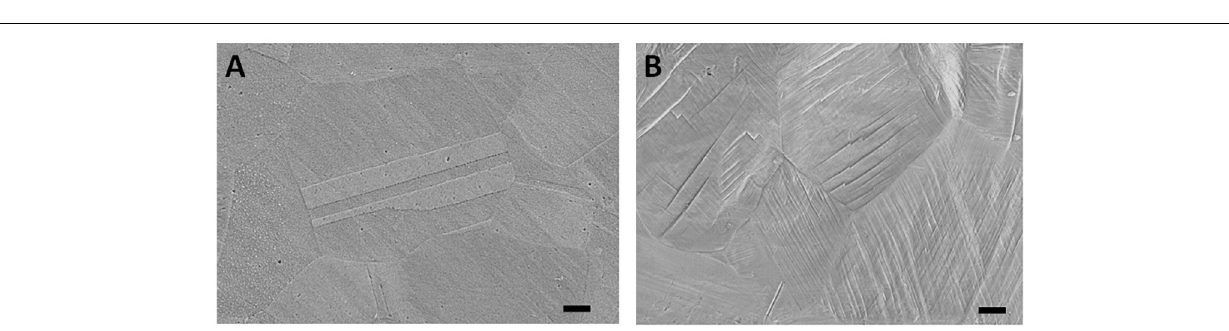
Frontiers in Materials |